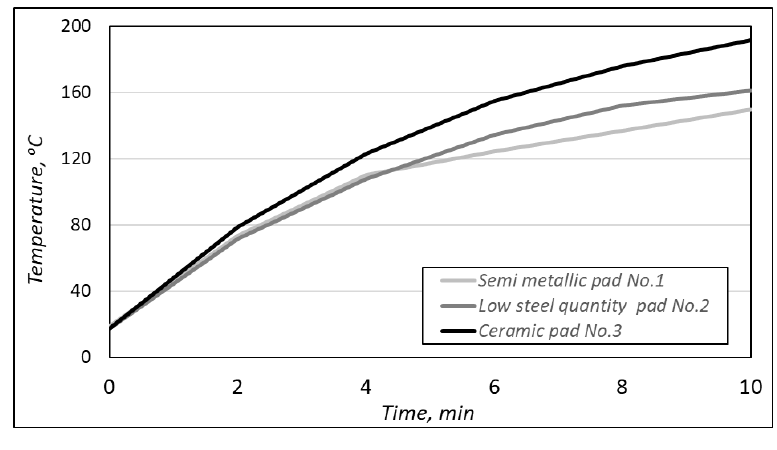
Fig. 4 Temperature of the brake discs during the testing of the pads of varied materials (sliding speed 1.75 m/s and contact pressure 0.85 MPa)